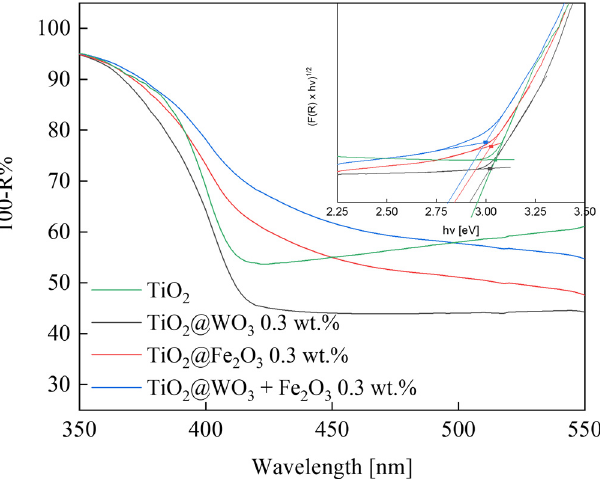
Figure 4. UV-vis spectrum of TiO 2 and nanocomposites based on TiO 2 . Tauc plot of analyzed samples in the inset.